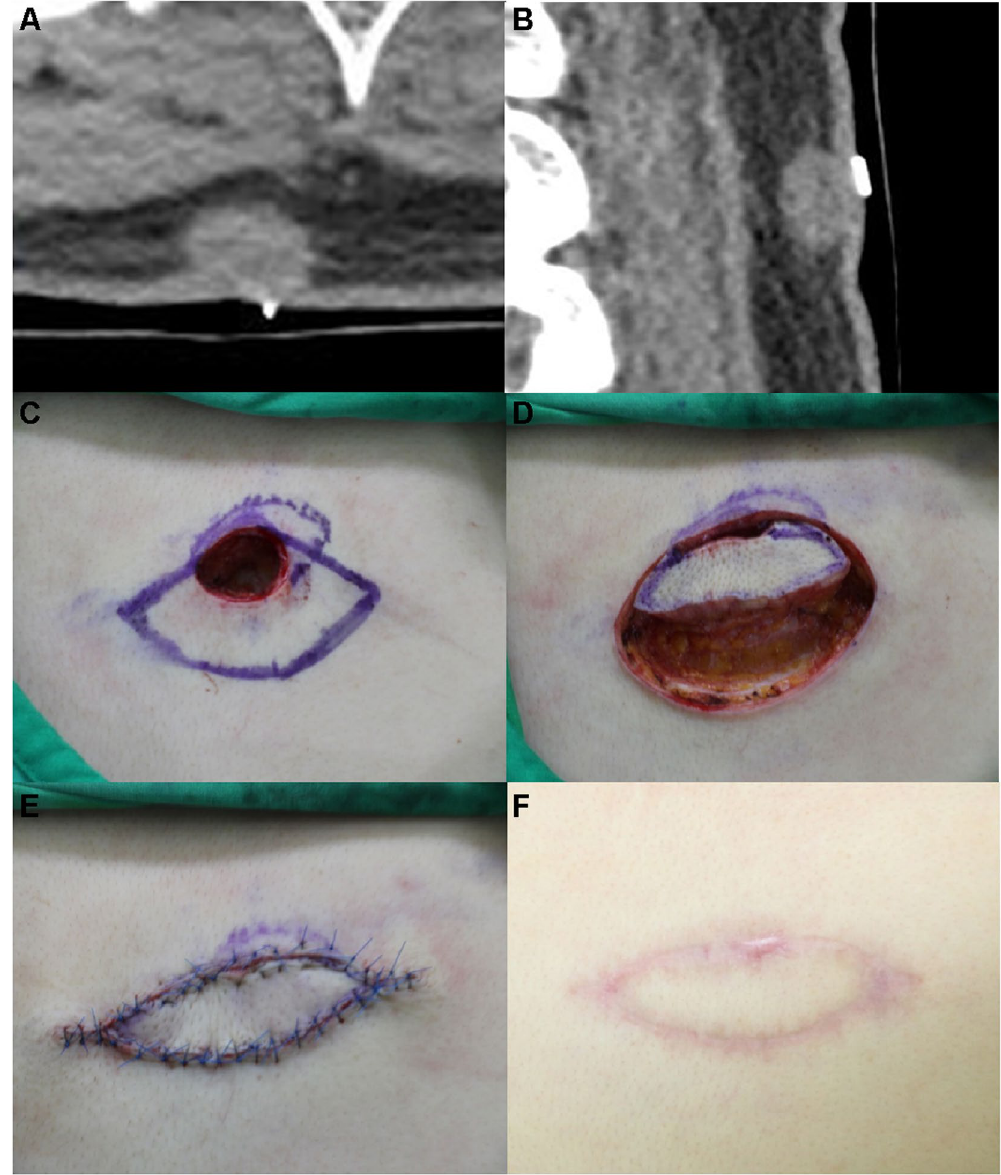
Figure 3. Keystone-design perforator island flap (KDPIF) reconstruction after complete excision of the ruptured epidermoid cyst (EC) in a 36-year-old woman. ( A , B ) Computed tomography scan revealed a 1.5 × 2 cm elliptical cystic lesion extending from the skin to the deep fat layer at the level of thoracic inlet. ( C ) The design of the flap. The final defect size was 2 × 2.5 cm and a 2 × 5 cm-sized KDPIF was designed in the lower side of the defect. ( D ) The island-form of the flap was designed and the flap was moved to the defect with minimal tension. ( E ) Postoperative clinical photograph immediately after the flap inset. ( F ) Postoperative clinical photograph of the flap after 10 months of